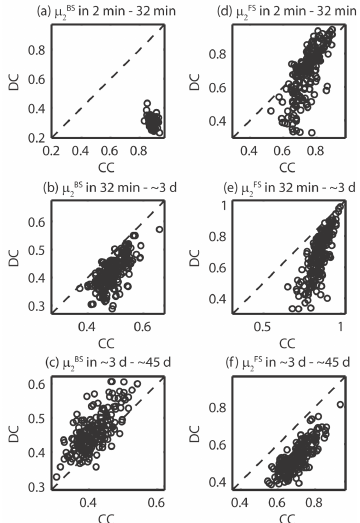
Fig. 11. Scatter plots between the clustering exponents φ computed for the signal sampled with CC (x-axis) and DC (y-axis) methods. Each panel refers to a given scaling ( µ FS ) for the three 2 2